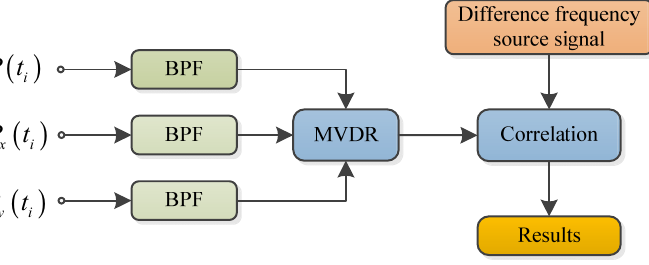
Figure 8. Signal-processing flow of sub-bottom echo signal based on a vector hydrophone.